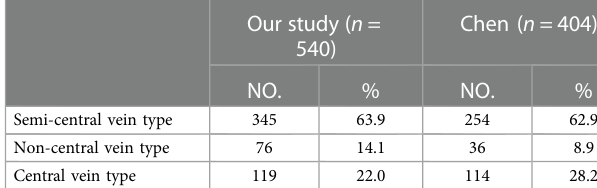
TABLE 3 Branching patterns of the left superior division veins.